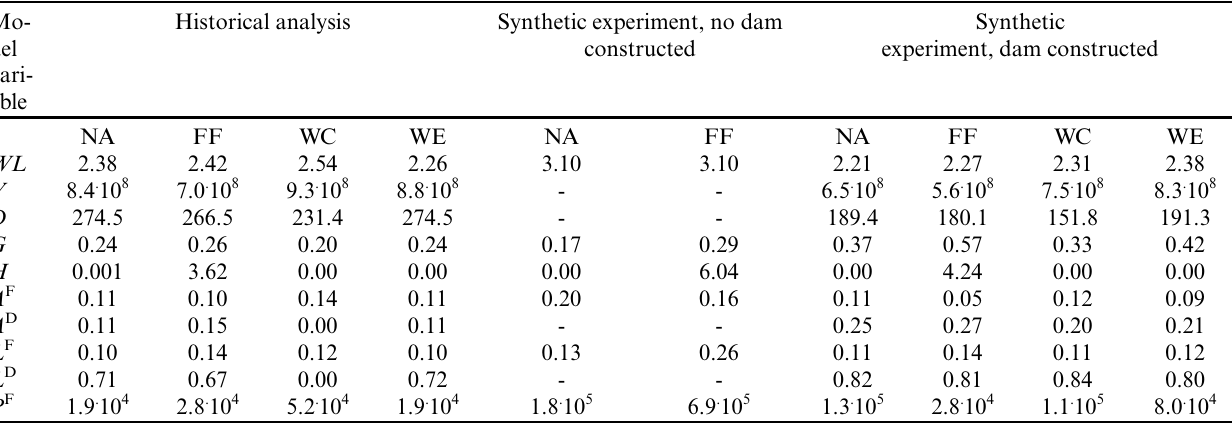
Table 5 . Average values of different model variables obtained for the different experiments with the four water-management strategies (NA: no actions; FF: fighting floods; WC: water conservation; and WE: water exploitation). Note: WL = high-water level; V = reservoir volume; D = per-capita water demand; G = proportion of population living in the floodplain; H = flood protection level; A F =